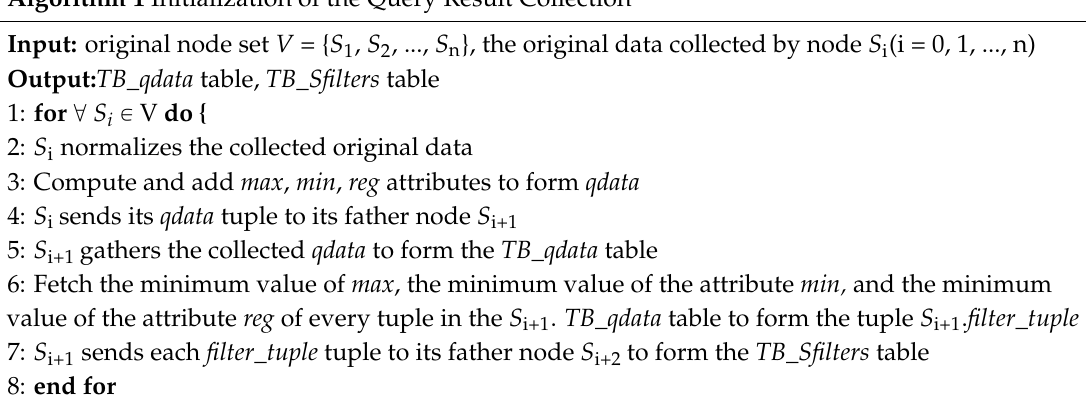
Algorithm 1 Initialization of the Query Result